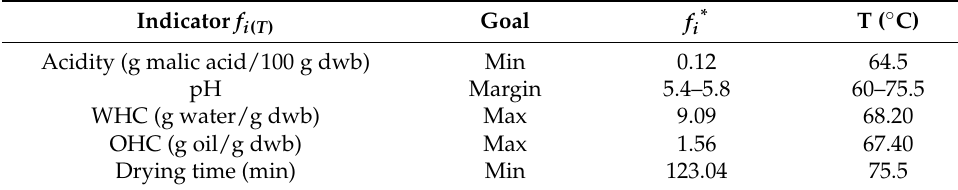
Table 4. Utopia vector.